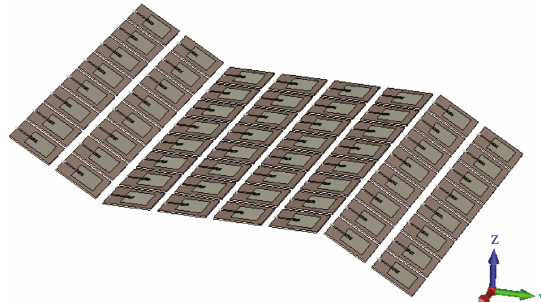
Figure 9: Investigated surface deformation for the 8 × 8 array.